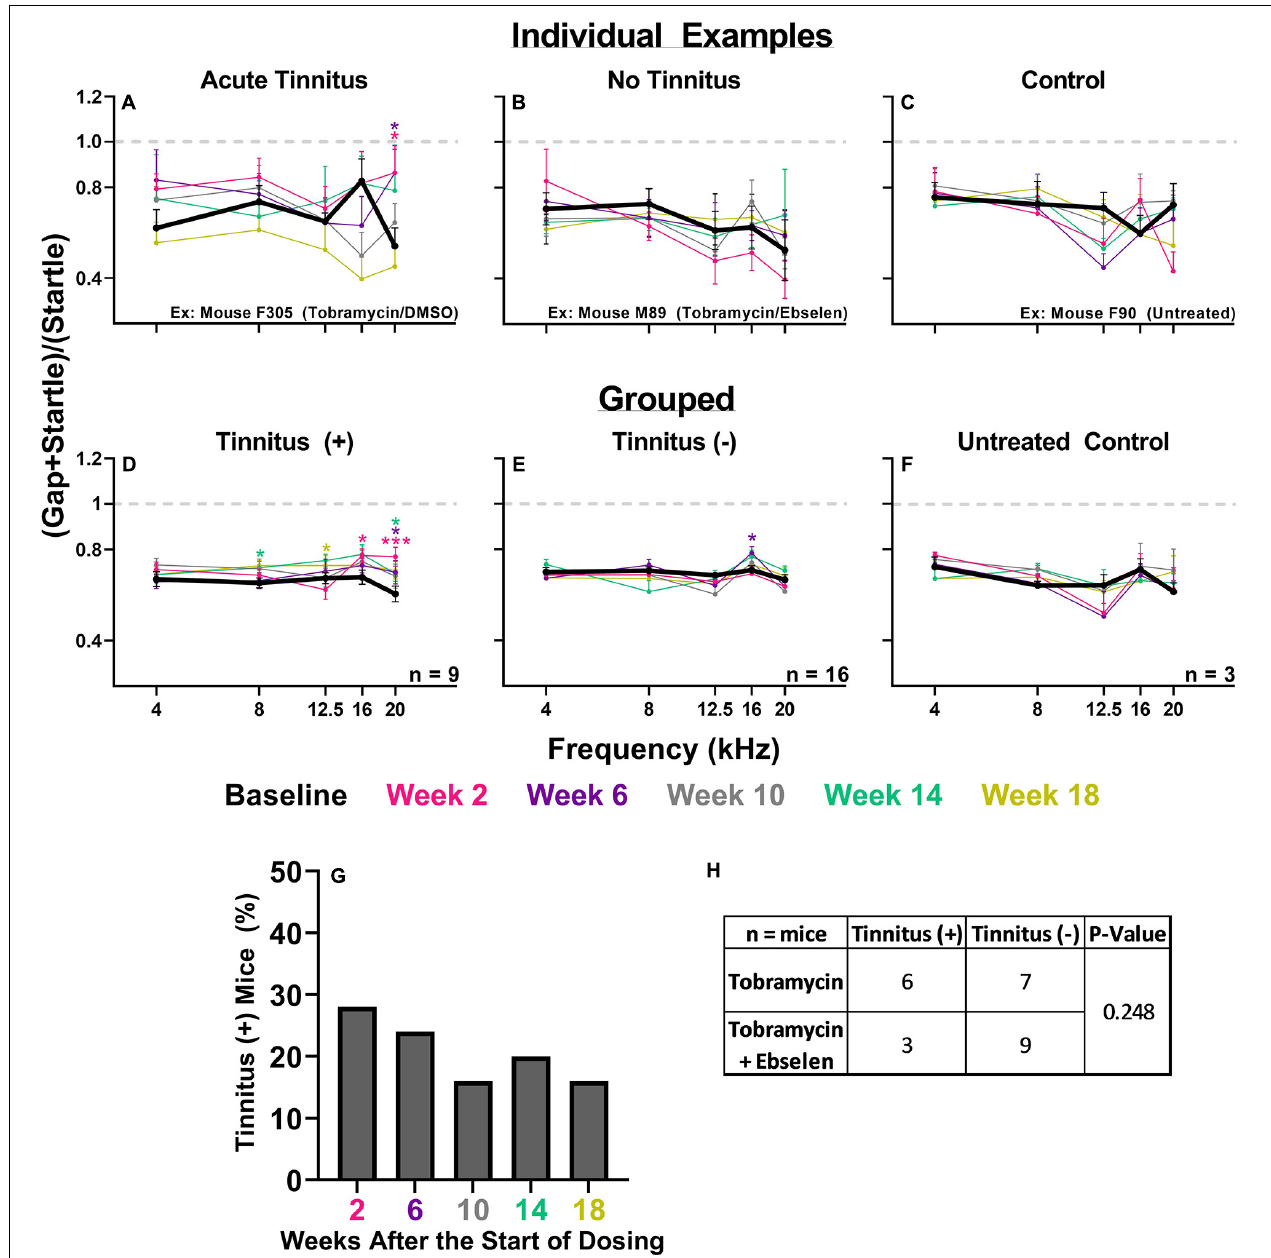
FIGURE 6 | Evaluation of behavioral evidence of tinnitus for individual animals and dosing groups. (A): Example GPIAS functions for a tobramycin treated mouse with behavioral evidence of acute tinnitus, (B): a treated mouse with no tinnitus, and (C): an untreated control mouse. (D): GPIAS functions for the group mean averages of tinnitus mice, (E): tinnitus negative mice, and (F): untreated control mice. Tinnitus was defined as a significant GPIAS deficit at 1 or 2 adjacent frequencies at any epoch (color coded) compared to baseline (bolded black line). Data is represented by ratio means and standard errors. Post hoc significant differences between specific epochs (color coded) and baseline are indicated as follows: * p ≤ 0.05; ** p ≤ 0.01; ***. (G): Histogram representing the % of all tobramycin treated mice which showed statistically significant gap detection deficits as described above at each epoch after dosing. (H): Contingency table for the development of tinnitus which shows the number of mice which met or did not meet the criteria for tinnitus. Each animal was analyzed independently. Two-sided Fisher’s exact tests were used statistically evaluate differences between tobramycin dosed groups.